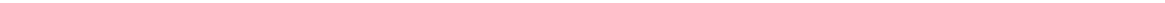
Fig. 1 β -1,3-glucan is required for NKp30-mediated killing of Cryptococcus . a Flow cytometric analysis of cryptococcal cell wall/membrane (CCW/M) binding to YT cells as detected by mAb to β -1,3-glucan vs. isotype control Ab. b Flow cytometric analysis of β -glucan binding to YT cell. YT cells were incubated with (left panel) or without (right panel) laminarin, a linear β -1,3-glucan with β -1,6-linkages. c Flow cytometric analysis of laminarihexaose binding to YT cells. YT cells were incubated with laminarihexaose (from curdlan, comprising only β -1,3-glucan). d Comparison of binding of pustulan vs. β - 1,3-glucan to YT cells analyzed using fl ow cytometry. YT cells were incubated with pustulan (comprising only β -1,6-glucan) or β -1,3-glucan (derived from S. cerevisiae ). This experiment was performed twice. e Flow cytometric analysis of a recombinant NKp30-Fc fusion protein binding to β -glucan-conjugated beads ( β -1,3-GB) compared to unconjugated polystyrene beads as control. NKp30-Fc on the beads was detected with anti-NKp30 antibody (1C01). f